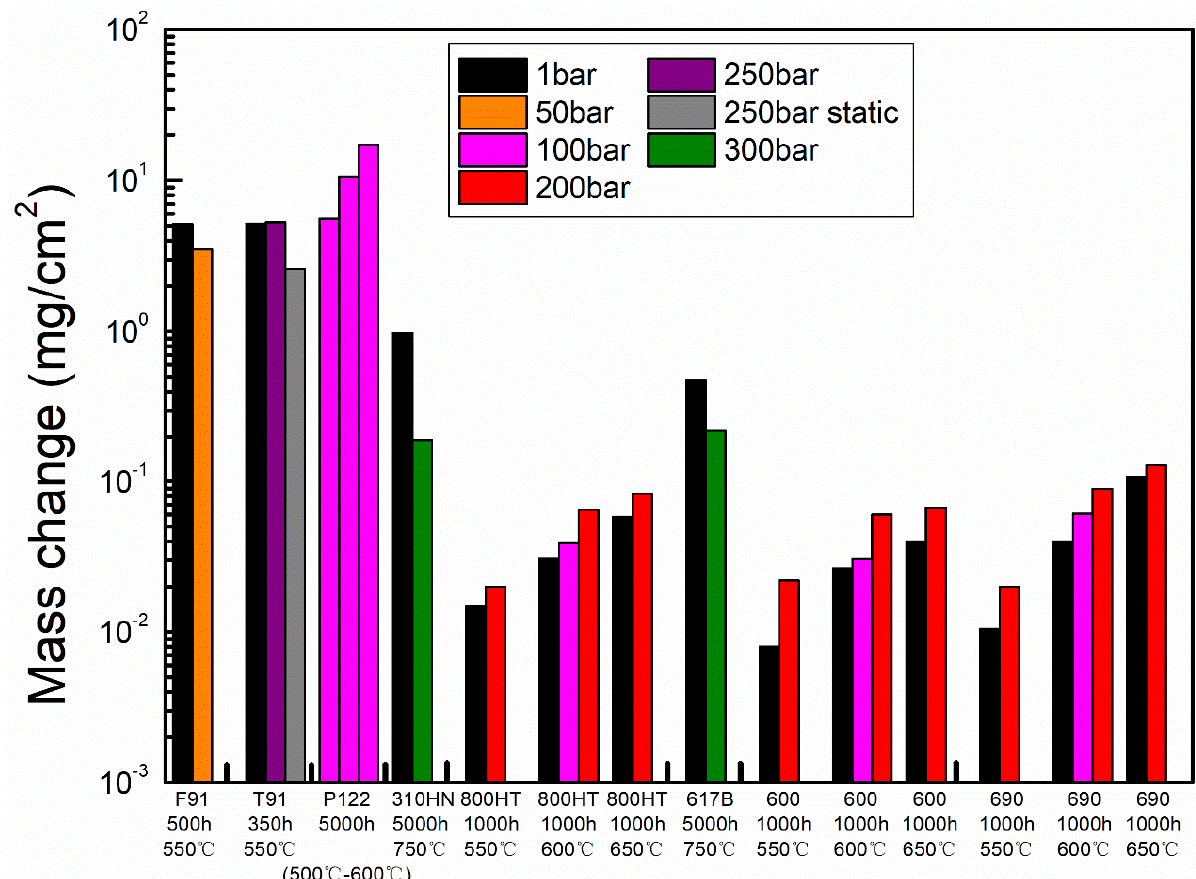
Figure 9. Correlation of mass change with temperature and pressure for different alloys in CO 2 gas. Data were obtained from references